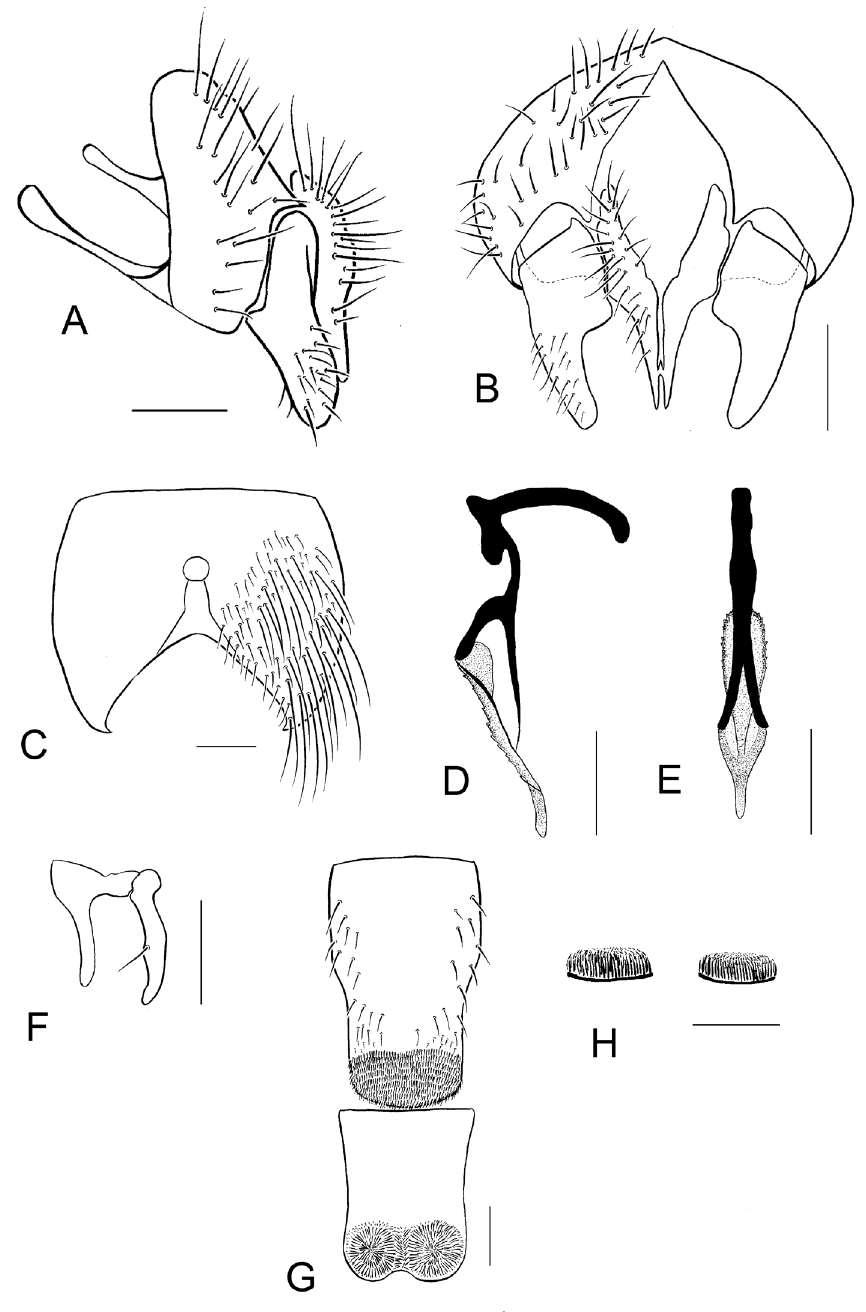
Figure 9. Sternites and genitalia of Paradichosia lui sp. n., ♂ . A Epandrium, cercus, and surstylus, lateral view B Cercus and surstylus, caudal view C Fifth abdominal sternite, ventral view D Aedeagus, lateral view E Aedeagus, posterior view F Anterior and posterior parameres G Third and fourth abdominal sternites, ventral view H Tufts on the third (left) and fourth (right) abdominal sternites. Scale bars: 0.2